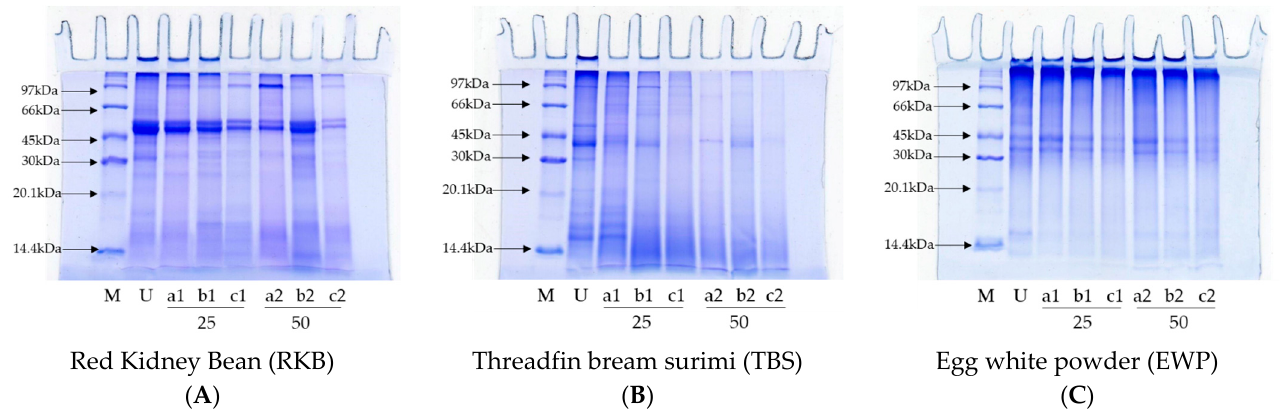
Figure 4. Protein patterns of ( A ) red kidney bean (RKB); ( B ) threadfin bream surimi (TBS); and ( C ) egg white powder (EWP) without digestion (U) and subjected to digestion under different simulated in vitro gastrointestinal (GI) tract conditions without and with tuna pepsin powder (TPP) and/or trypsin-loaded beads (TLB) at different levels. a: In the absence of TPP b: In the absence of TLB and c: In the presence of both TPP and TLB. Number denotes the level of enzymes (%, based on protein content). M: Low molecular weight marker.